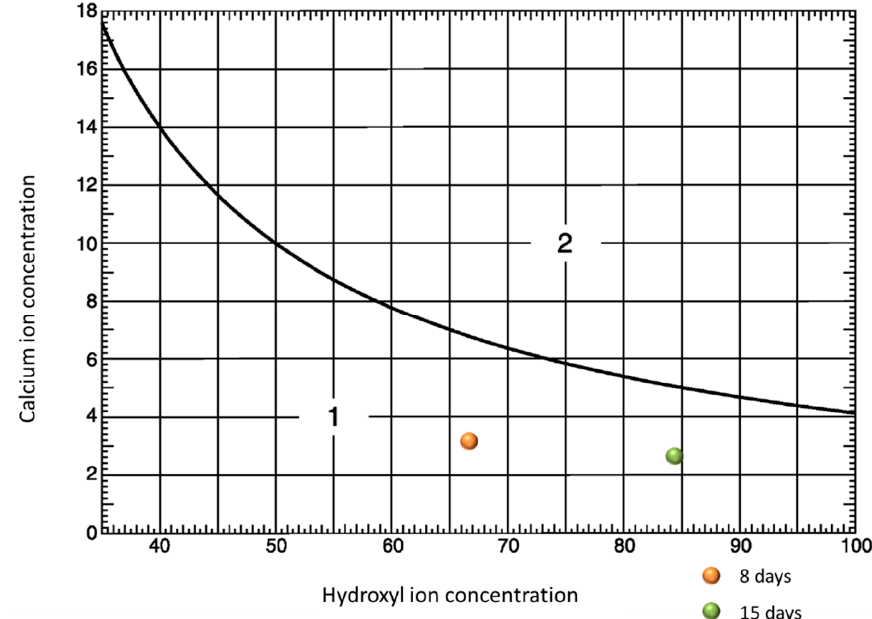
Figure 3. Graphs of concentration of Ca(OH) 2 and hydroxyl ions (mmol/L), depicting the behaviour of pozzolanic reactivity at 8 and 15